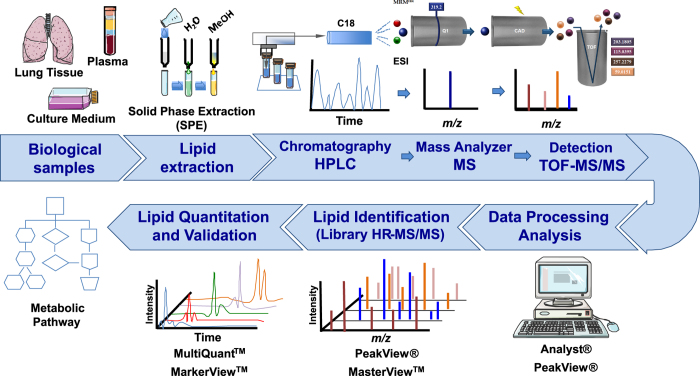
Experimental workflow of lipid mediators analysis using MRMHR.Various biological samples, such as lung tissue, plasma and culture medium, were prepared by solid phase extraction (SPE) for subsequent UHPLC-MS/MS analysis. The scheme of MRMHR analysis was represented by 5-HETE detection (precursor ion at m/z 319.2 and fragment ions at m/z 257.2279, 203.1805, 115.0395 and 59.0151) in a complex mixture. The lipids were identified and quantified using bioinformatics software package. A library of HR-MS/MS profile was created for each metabolite quantified. A partial validation of MRMHR method was conducted according FDA recommendations.